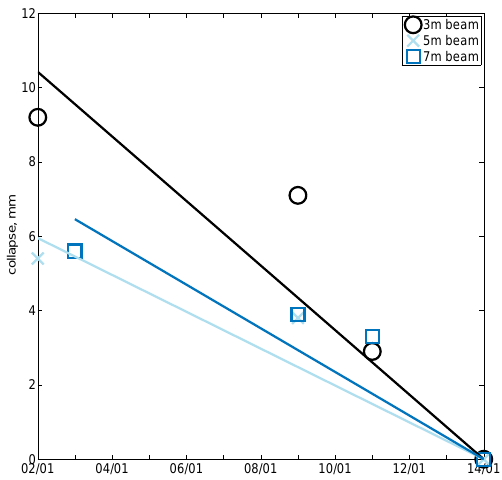
Figure 7. Decreasing collapse amplitudes with time. Collapse am- plitudes were averaged across each beam. Tests 1–8 shown. Regres- sion lines were forced through 13/01 and 14/01, when all tests had no propagation (collapse amplitude 0mm). The average slope coef- ficient is -0.65mmday − 1 .